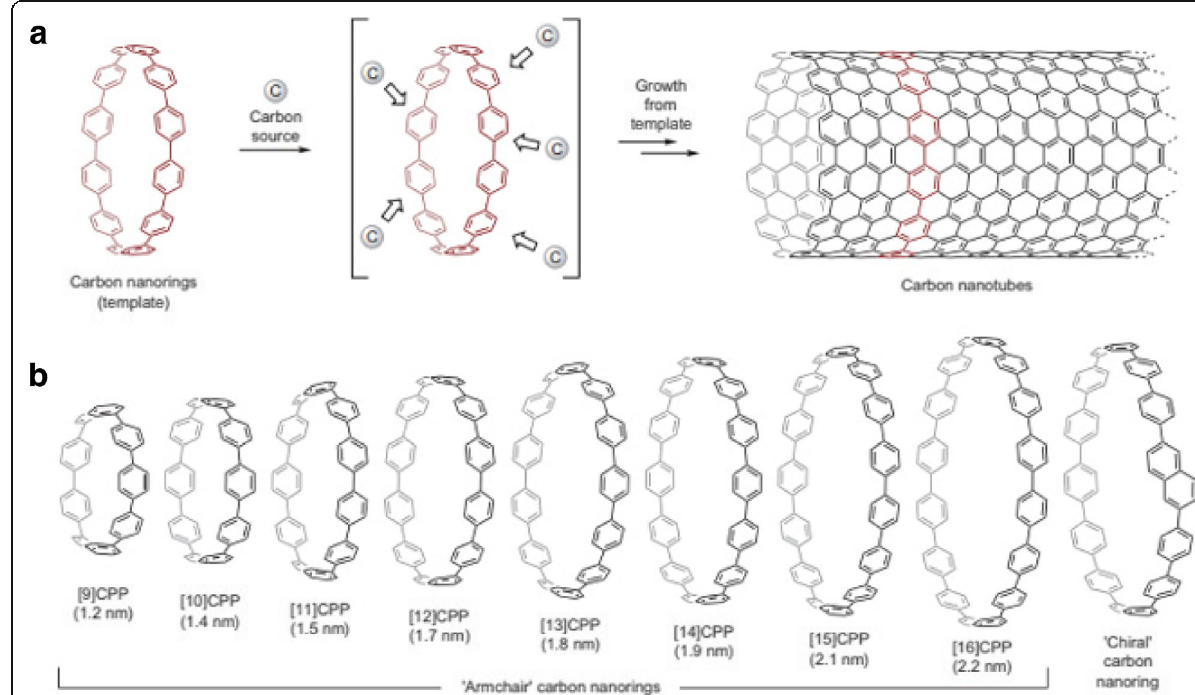
Fig. 16 a Schematic of template-based CNT growth using carbon nanorings (cycloparaphenylene) that represent the shortest sidewall segment of armchair CNTs. Adapted from [126]. b Representation of various carbon nanorings grown using the template-based method and their corresponding diameters in nm. Adapted from